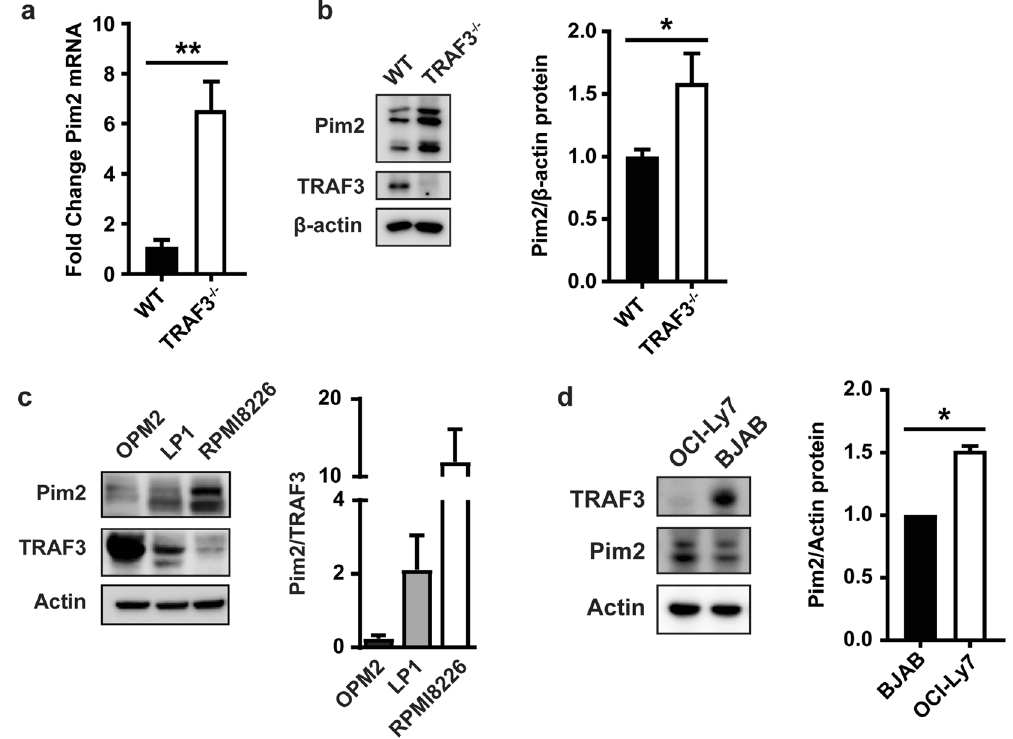
Figure 1. TRAF3-mediated regulation of Pim2 expression in mouse primary B cells and human MM and BCL cell lines. ( a ) Pim2 mRNA levels in WT and TRAF3 − / − B cells were determined by RT-PCR. Data were normalized to GAPDH and fold change was determined using the comparative Ct method. Graph depicts mean values ± SEM (N = 3 mice). An unpaired t test was used to evaluate differences for statistical significance ( ** p < 0.01). ( b ) Whole-cell lysates (WCLs) of WT and TRAF3 − / − B cells were analyzed with Western blotting (WB) for protein expression. Graphs depict mean values ± SEM with (N = 8 mice from 2 independent experiments). Samples were normalized first to the β -actin loading control and then to the average WT normalized value. An unpaired t test with Welch’s correction was used to evaluate differences for statistical significance ( * p < 0.05). ( c , d ) Relative levels of TRAF3 and Pim2 in indicated human MM ( c ) and DLBCL ( d ) cell lines were determined with WB. Representative blots from 3 ( c ) and 6 ( d ) independent experiments are shown. Graph in ( c ) represents relative levels of Pim2/actin divided by TRAF3/actin of the indicated MM cell lines (N = 3). Graph in ( d ) depicts mean values ± SEM. ( c , d ) were previously presented in the